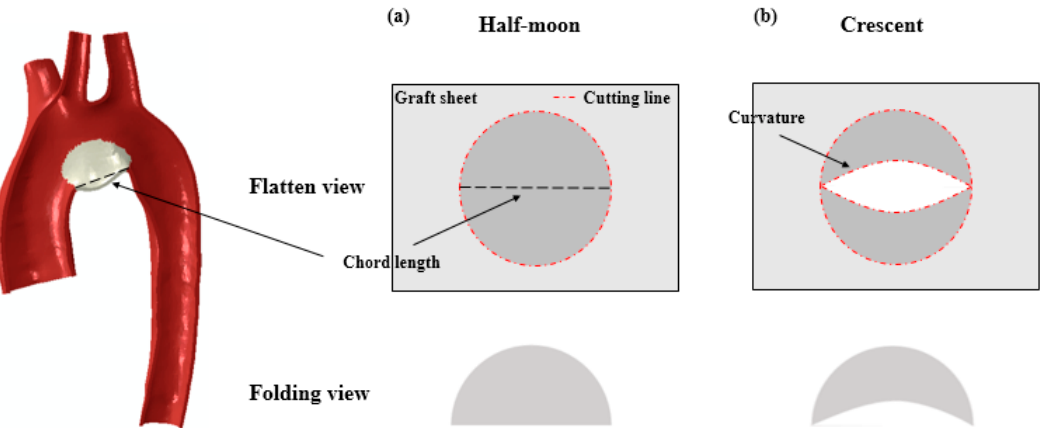
Figure 1. Schematic diagrams of ( a ) a half-moon shaped graft and ( b ) a crescent graft in flatten (Top) and folding views (Bottom). The chord length of the native arc, measured from the echocardiography, was used to create graft shapes.